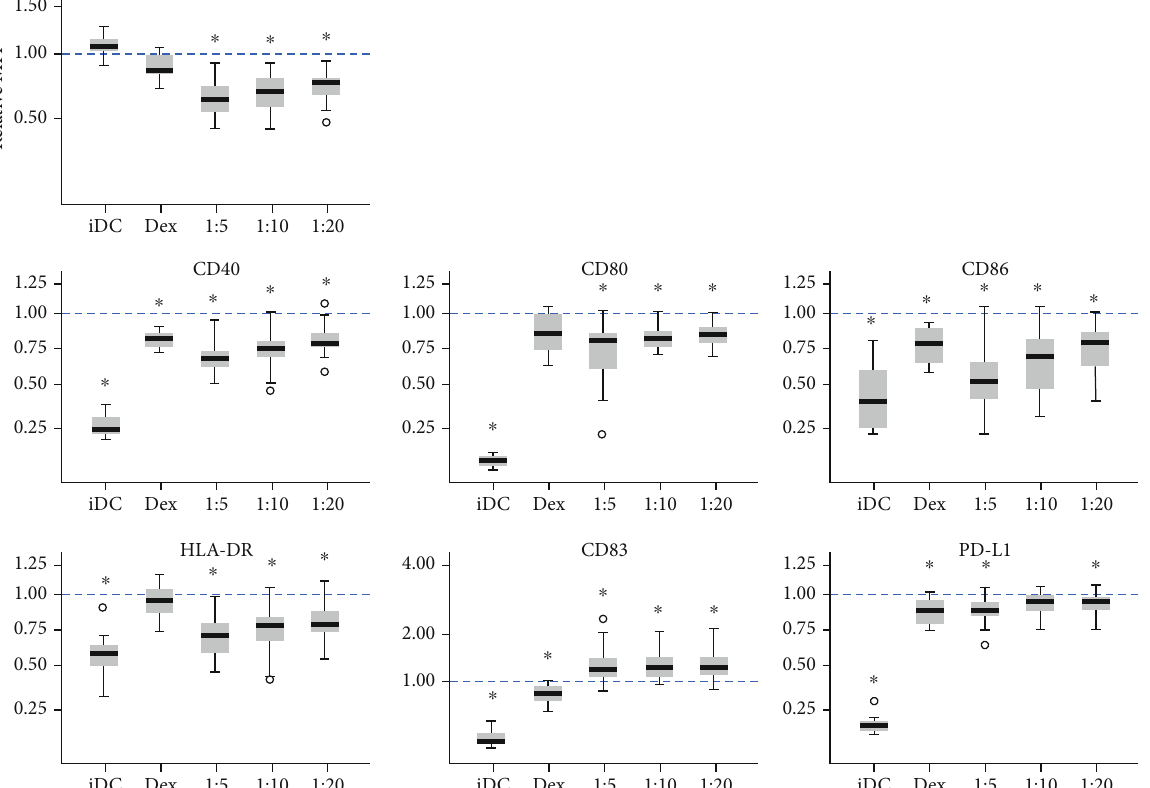
Figure 3: Expression of surface markers on dendritic cells. The dotted line indicates the level of mDC (1). 1 :5-1: 20 refer to ratios of ASC :DC. iDC: immature dendritic cell; Dex: dexamethasone control; mDC: mature dendritic cell; ASC: adipose tissue-derived stromal cell. Signi fi cant di ff erences from mDC (adjusted p ≤ 0 : 05 ) marked with an asterisk ( ∗ ). n = 20 , resulting from 5 ASC donors and 4 DC